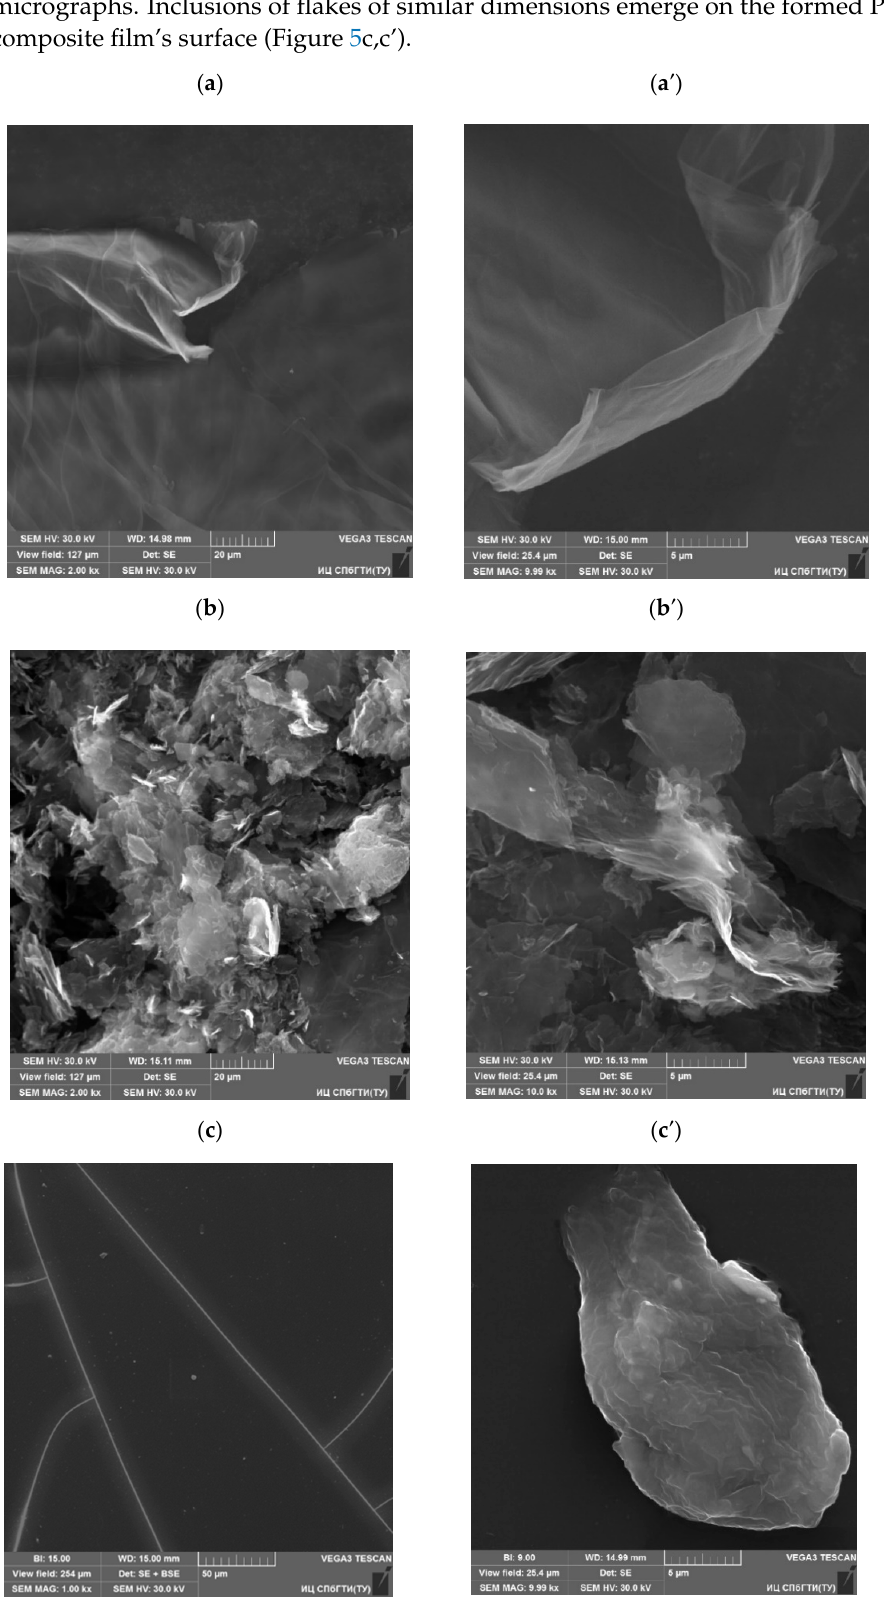
Figure 5. Scanning electron microscopy (SEM) micrographs of the initial ( a , a’ ), surface modified r-GO flakes ( b , b’ ) and a film surface for composite 2 ( c , c’ ) taken at 1 k × ( c ), 2 k × ( a , b ) and 10 k × ( a’ , b’ , c’ ) magnifications. The r-GO was obtained in an H ₂ atmosphere.